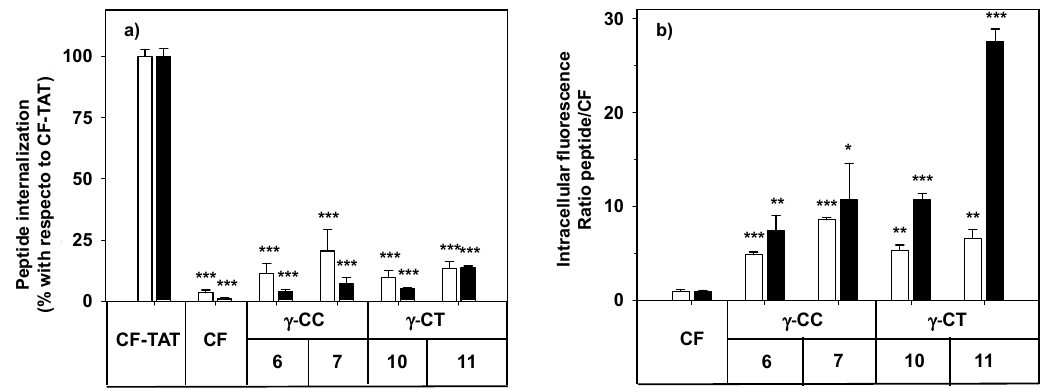
Figure 2. Cytotoxicity of peptides 4 – 11 on HeLa cells. Peptides with ( a ) terminal free amino group; ( b ) terminal amino group conjugated with CF. Cells were incubated with the respective peptide for 24 h and their viability assayed by 3-(4,5-dimethylthiazol-2-yl)-2,5-diphenyltetrazolium bromide (MTT) reduction. Cell viability was expressed as the percentage of MTT reduction with respect to control cells ± SD. Statistical significance with respect to control cells: p ≤ 0.05 (*). Samples were made in quadruplicate, and experiments were repeated thrice independently.